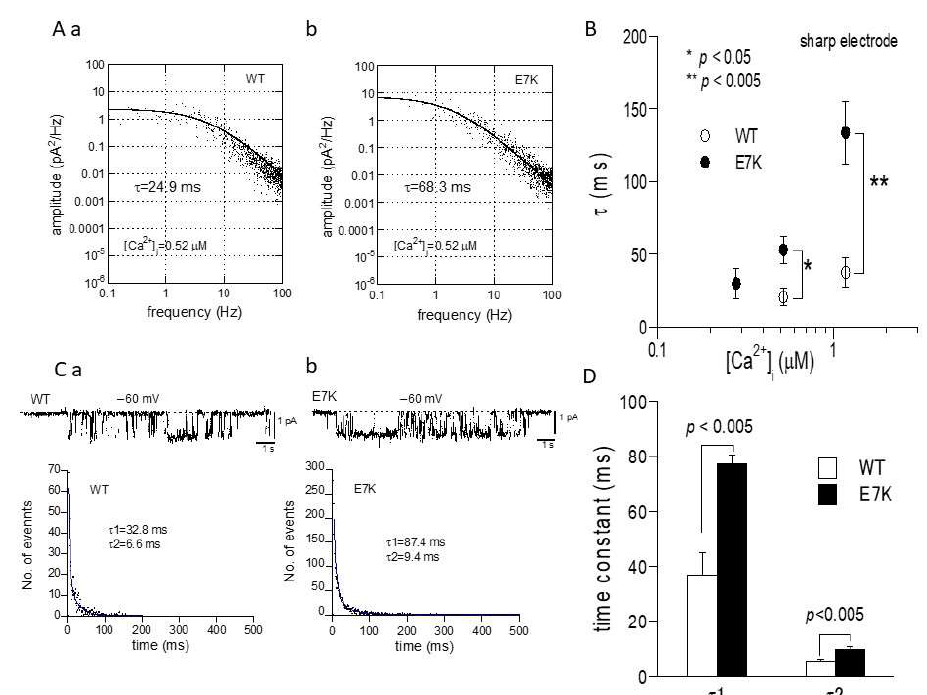
Figure 4. Noise spectrum and single channel analyses of E7K channel gating. ( A ) representative spectral density plots of wild-type (a) and E7K-TRPM4 (b) whole-currents at −60 mV at 0.52 μM [Ca 2+ ] i . Each plot is fitted by the equation: s(f) = s(0)/[1 + (f/f c ) 2 ] (see the Methods). The value of time constant (τ) is calculated according to the relationship: τ = 1/2πf c . The τ value would provide a reasonable estimate for the open life-time, provided that the rate of closing is much larger than that of opening, i.e., near the resting membrane potential (see Figure 3). To minimize the desensitization/rundown of currents, sharp patch electrodes were used to infuse desired [Ca 2+ ] i into the cell. ( B ) summary of spectrum analysis such as shown in A. Open and filled circles and bars indicate the means ± S.E.M.s of τ at 0.28, 0.52 and 1.17 μM [Ca 2+ ] i ( n = 4–8). Each condition was tested independently. Only the data at the same [Ca 2+ ] i was compared by unpaired t -test. *, **: p < 0.05 and 0.005. ( C ) representative traces of single channel activities at −60 mV (upper) and their respective dwell-time histograms (lower) for wild-type (a) and E7K-TRPM4 (b) channels. Their dwell-time histograms (shown in dots) are fitted by a sum of two exponentials with fast and slow time constants of τ1 and τ2. ( D ) averaged values of τ1 and τ2 with S.E.M bars for wild-type and E7K-mutant TRPM4 channels. n = 7. p values are the results of unpaired t -tests.